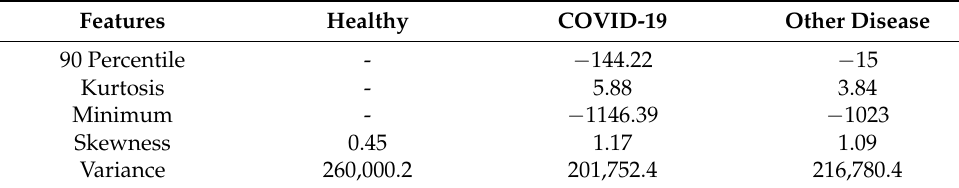
Table 3. Average values for healthy, COVID and lung disease patients. For healthy patients, there are only two parameters because these are the most discriminant for distinction by sick patients. In fact, these five features belong to the second-tier classification (see Tables 1 and